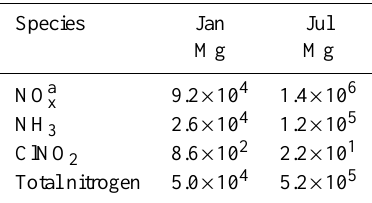
Table 2. Monthly emissions totals for naturally occurring nitrogen gases within the atmospheric modeling domain.